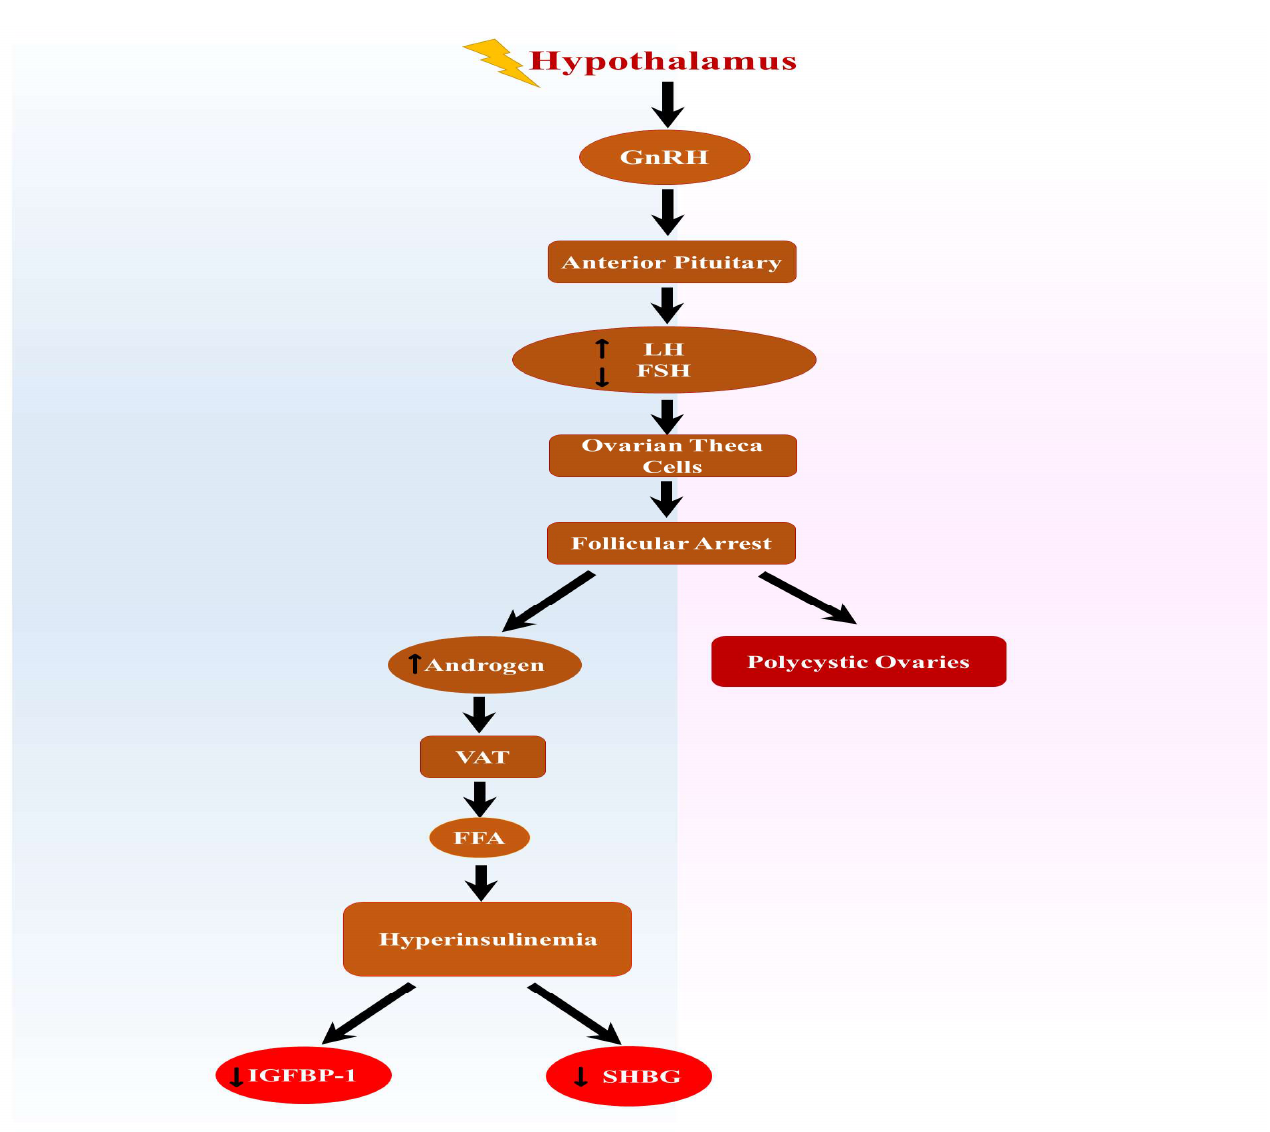
Figure 1. Overstimulation of the hypothalamus results in the enhanced secretion of luteinizing hormone and decreases FSH. A decrease in FSH prevents follicular development and enhances androgen release, leading to polycystic ovaries. Elevated androgen levels stimulate VAT, which increases FFA and results in hyperinsulinemia with reduced SHBG and IGFB-P1. Abbreviations: FSH, follicular stimulating hormone; VAT, visceral adipose tissue; FFA, free fatty acids; SHBG, sex hormone binding globulin; and IGFBP-1, insulin-like growth factor-binding protein 1. Steroid hormone synthesis in the ovaries is based on the two-cell, two-gonadotropin theory, referring to the compartmentalization of steroid hormone production.